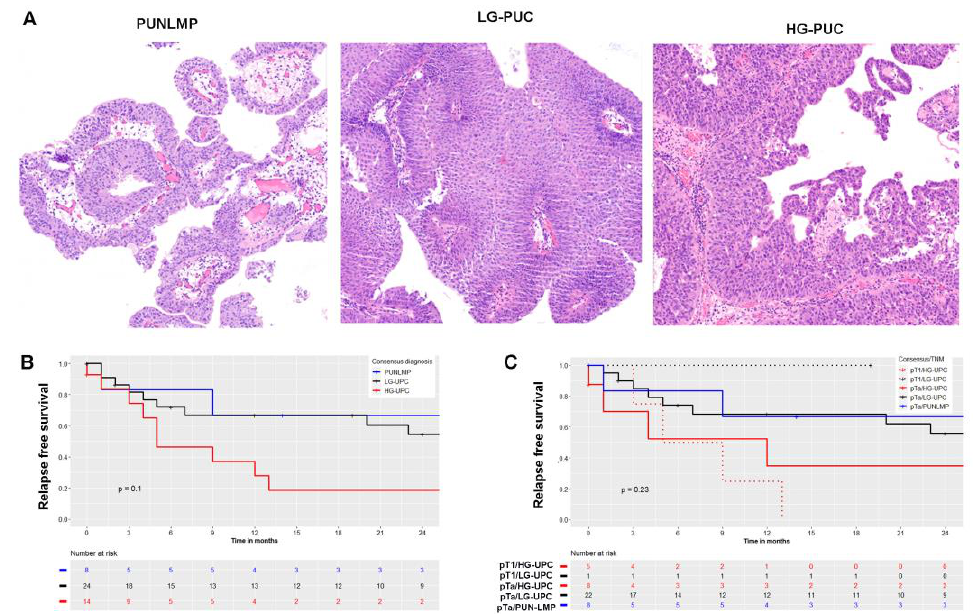
Figure 1. Histological grading and relapse-free survival . ( A ). Representative histology images dis-